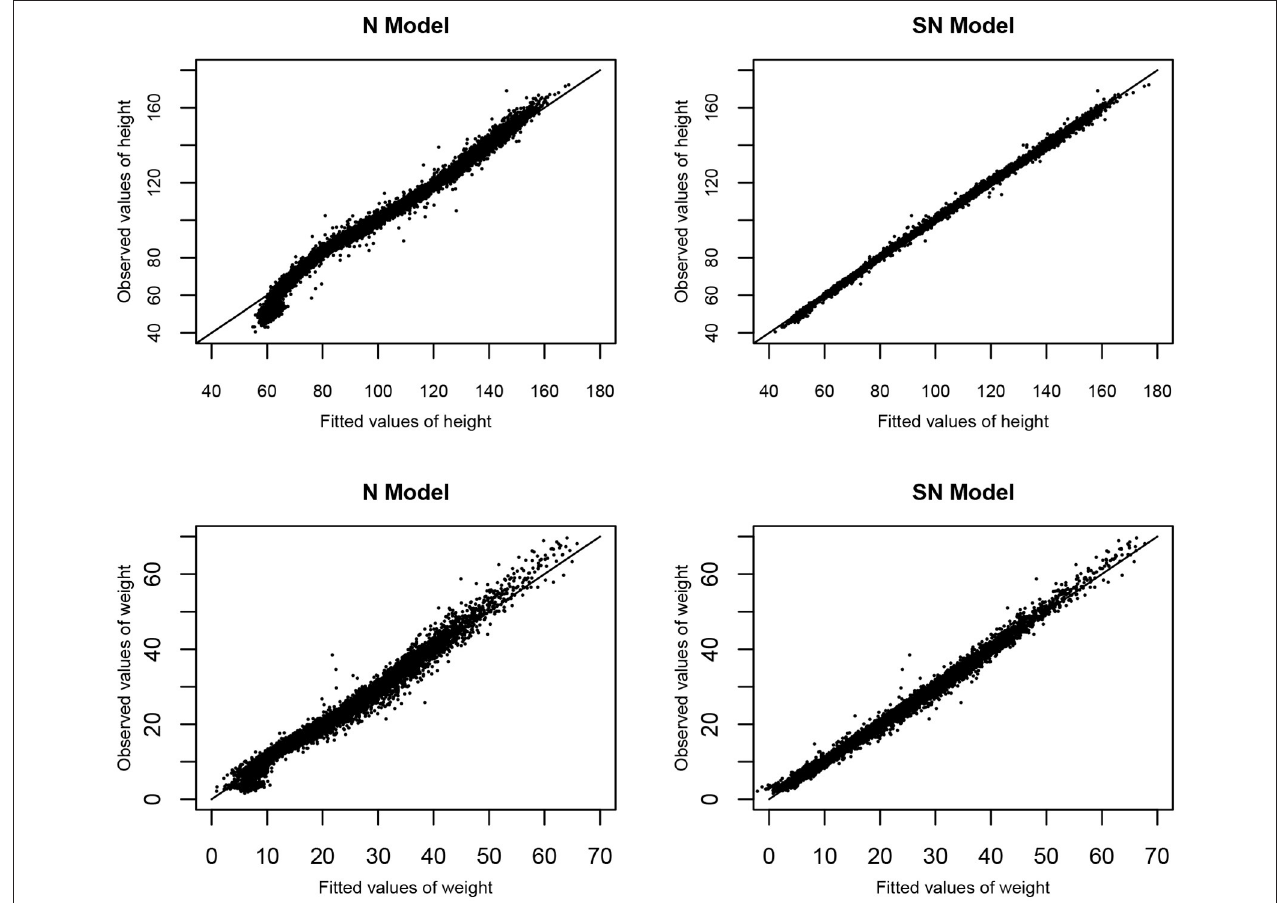
FIGURE 4 | The goodness of fit: Observed values verse fitted values of height and weight based on Models N and SN.